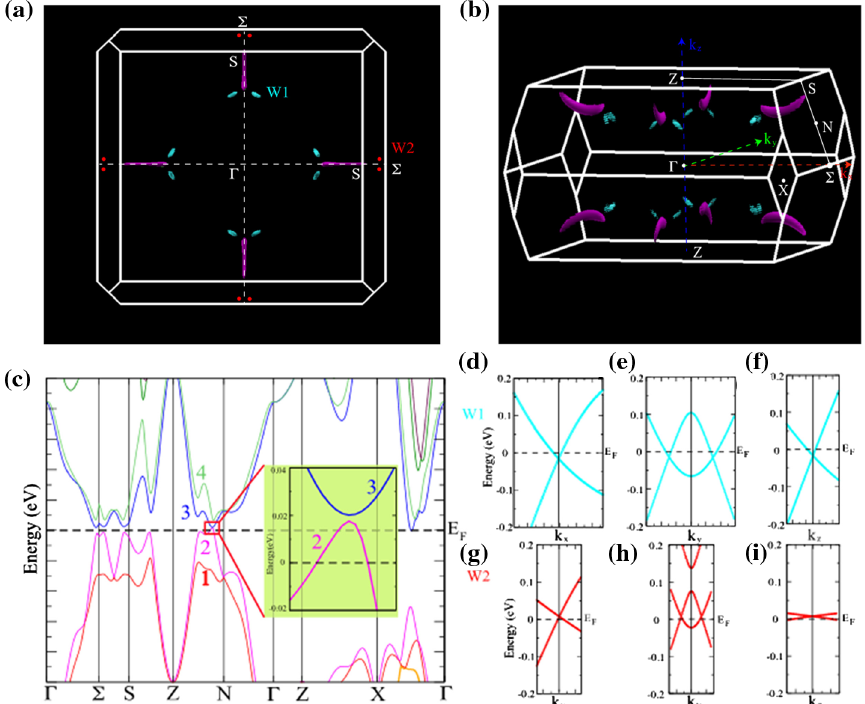
4. Theoretical analyzing of Fermi surfaces in TaAs. (a,b) First-principles-calculated Fermi surfaces in the top view and side view, respectively. (c) The band structure with SOC included. (d – f) and (g – i) Band structure around Weyl nodes in the k z ¼ 0 . 592 π (W1) and k ¼ 0 (W2) planes along the k k k z x , y , and z directions,